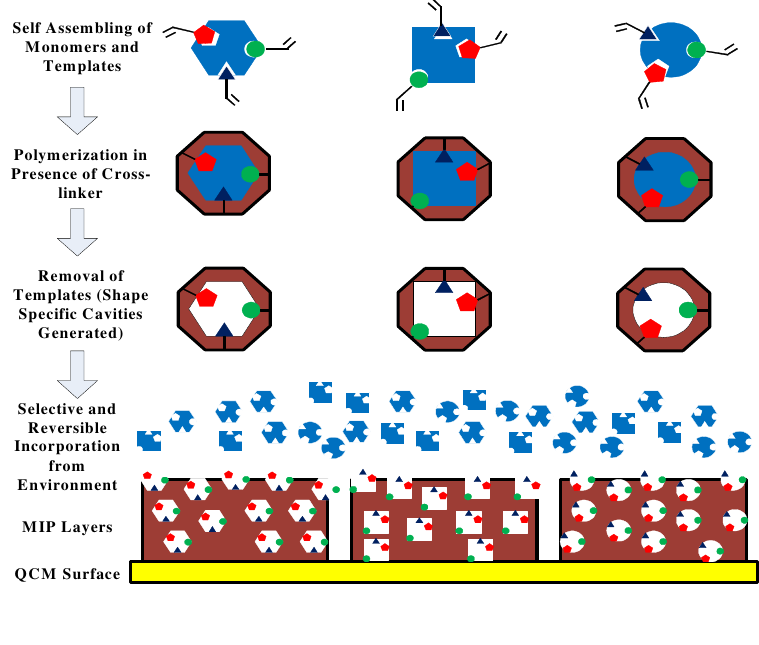
Figure 10. Generation of selectivity through molecular